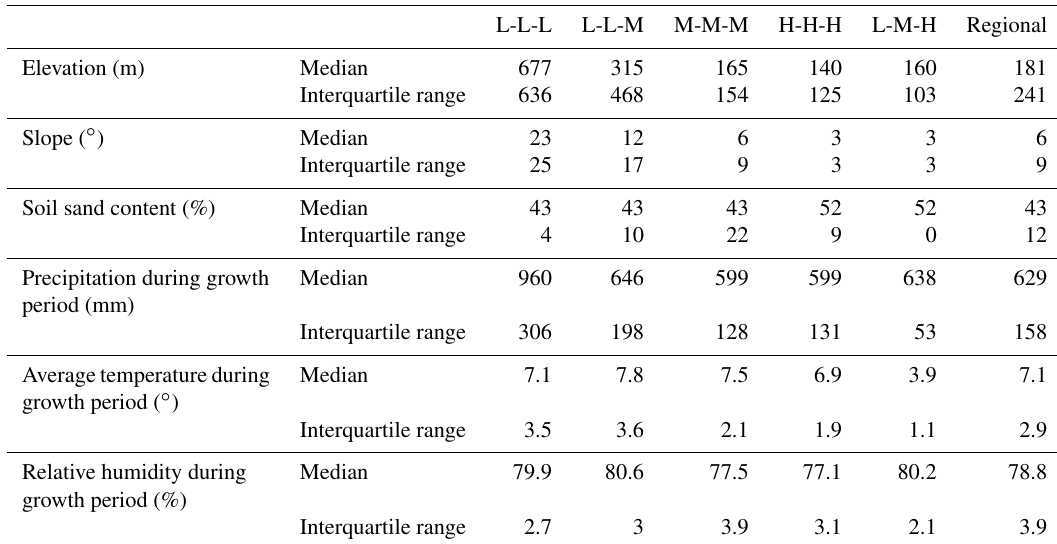
Table C1. Descriptive statistics of environmental variables in various loss-type